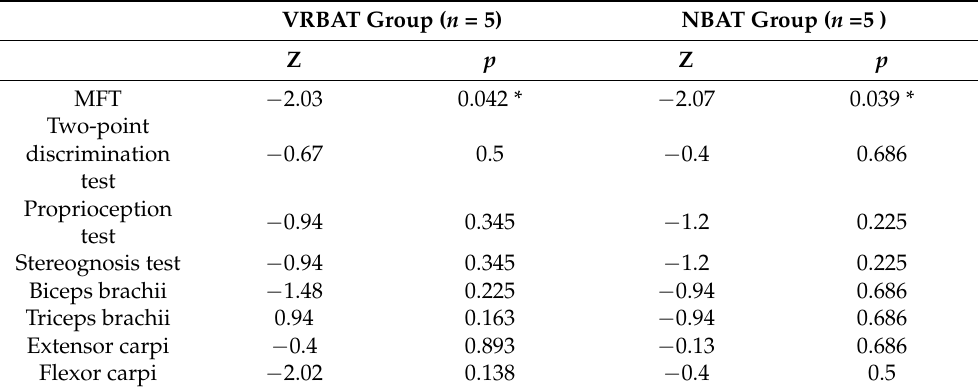
Table 2. Wilcoxon Signed-Rank test, pre- and